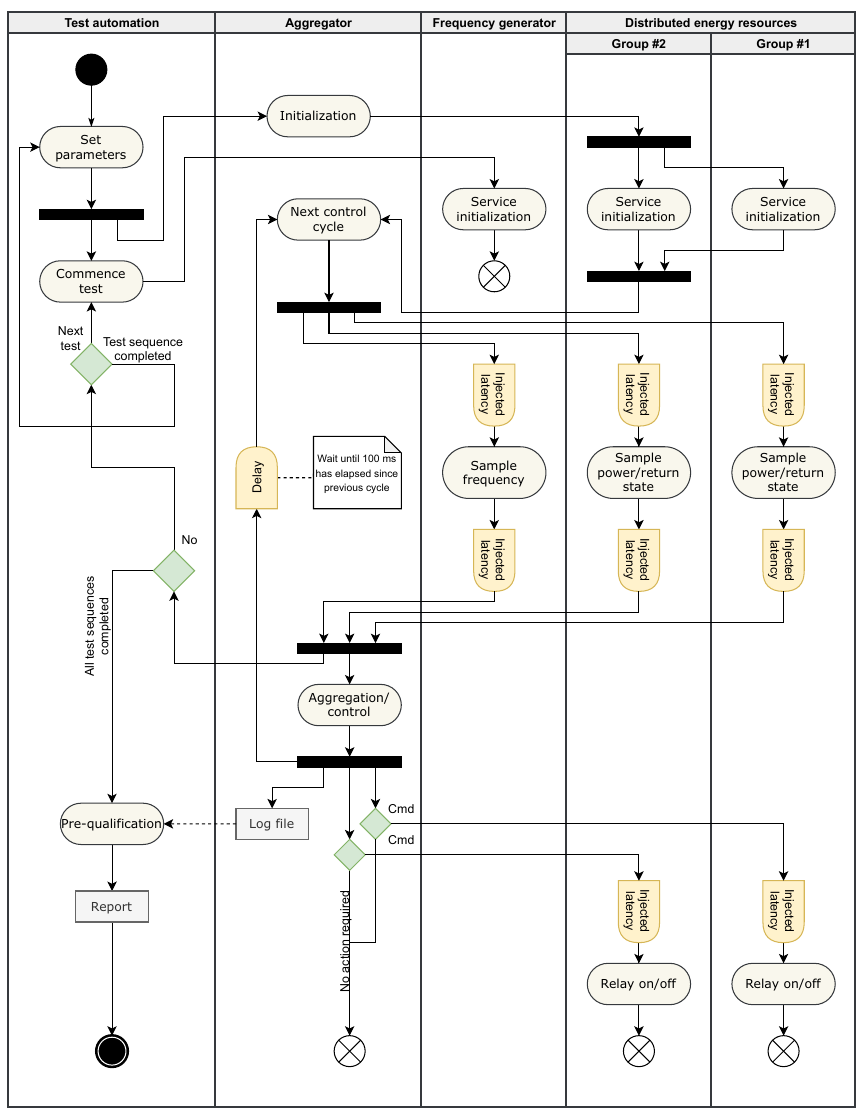
Figure 4. UML activity diagram depicting the validation setup introduced in Section